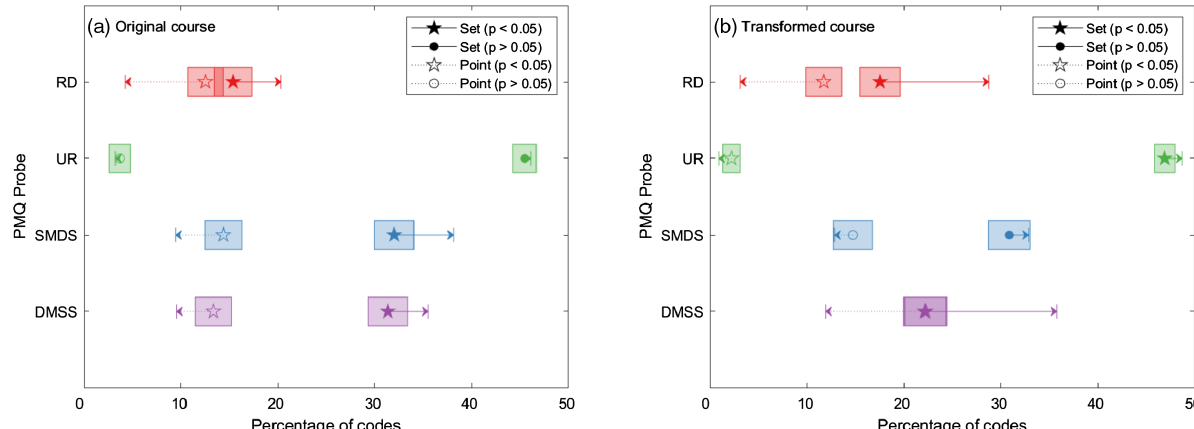
FIG. 3. Pre-post shifts at the probe paradigm level. (a) Before transformation; (b) after transformation. The horizontal axis represents the proportion of students responding in either the point or set paradigm, on each of four probes along the vertical axis. The shapes at the start of each arrow represent the pre-test proportion, while the location of the arrowhead represent the post-test proportion. Solid shapes represent the set paradigm proportion, while open shapes represent the point paradigm proportion. Star shapes represent a statistically significant pre-to-post shift using Fisher ’ s exact test at the 95% confidence level; circle shapes represent a shift that is not significant by that same test. Shaded boxes represent the pre-test binomial proportion confidence interval at the 95% confidence level, as a guide to the